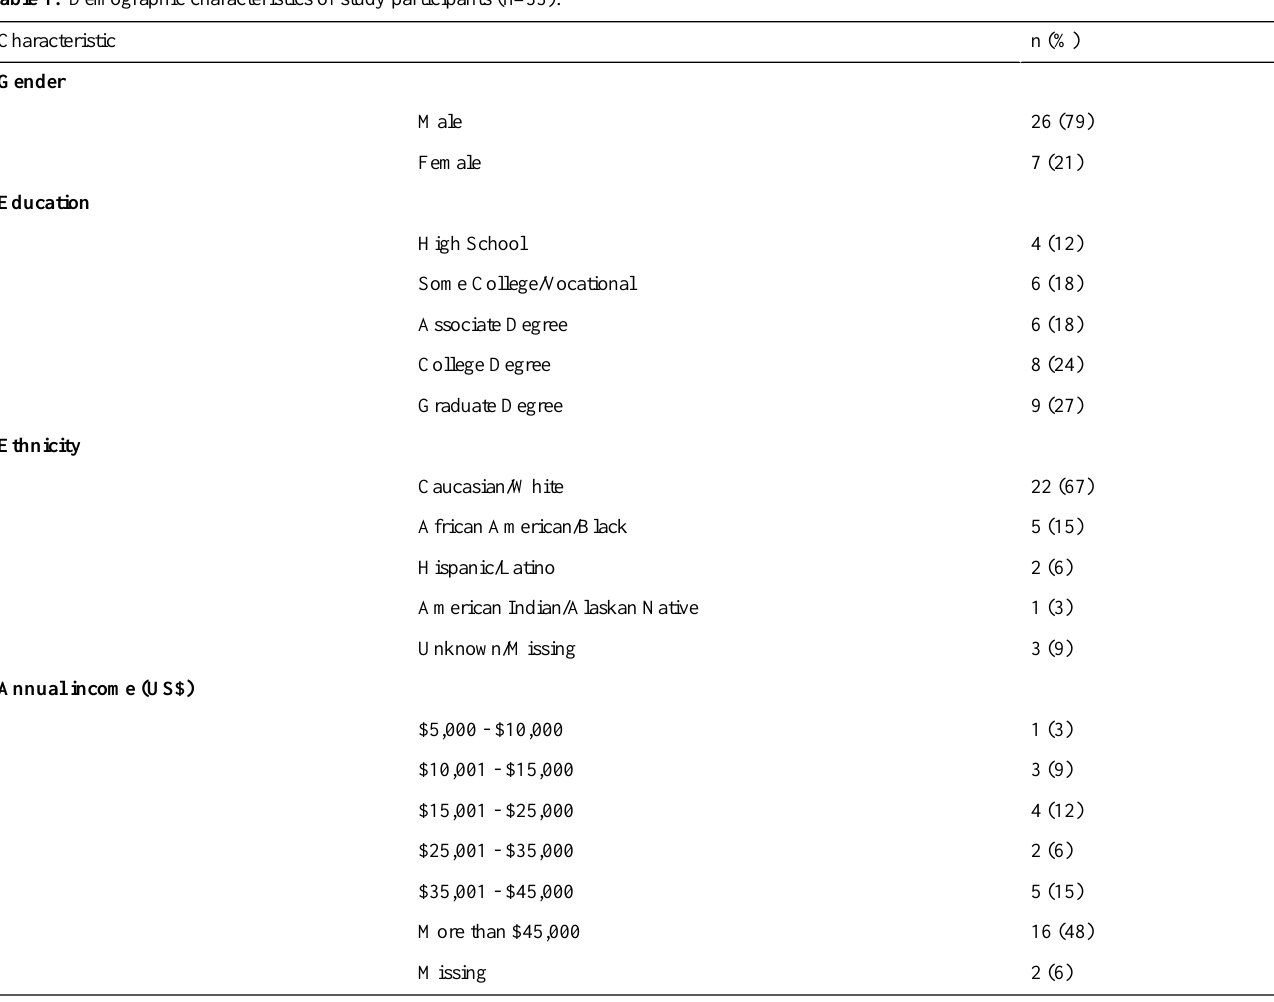
Table 1. Demographic characteristics of study participants (n=33).